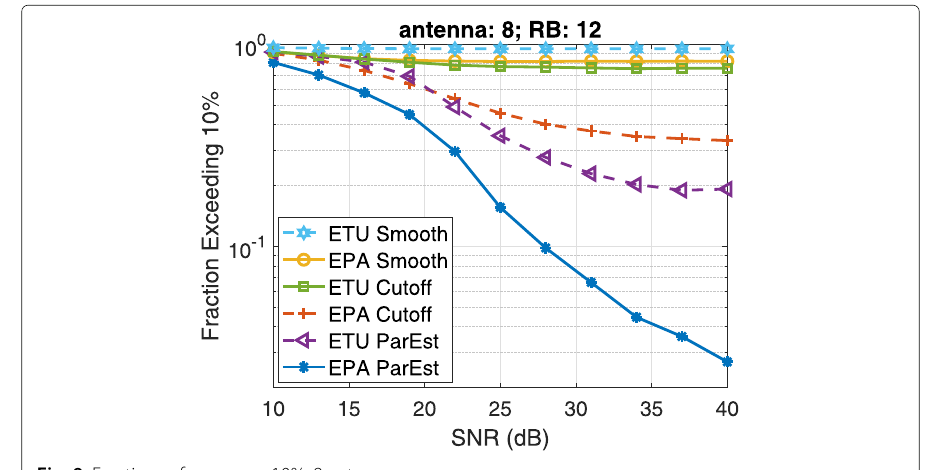
Fig. 9 Fractions of error over 10%. 8 antennas